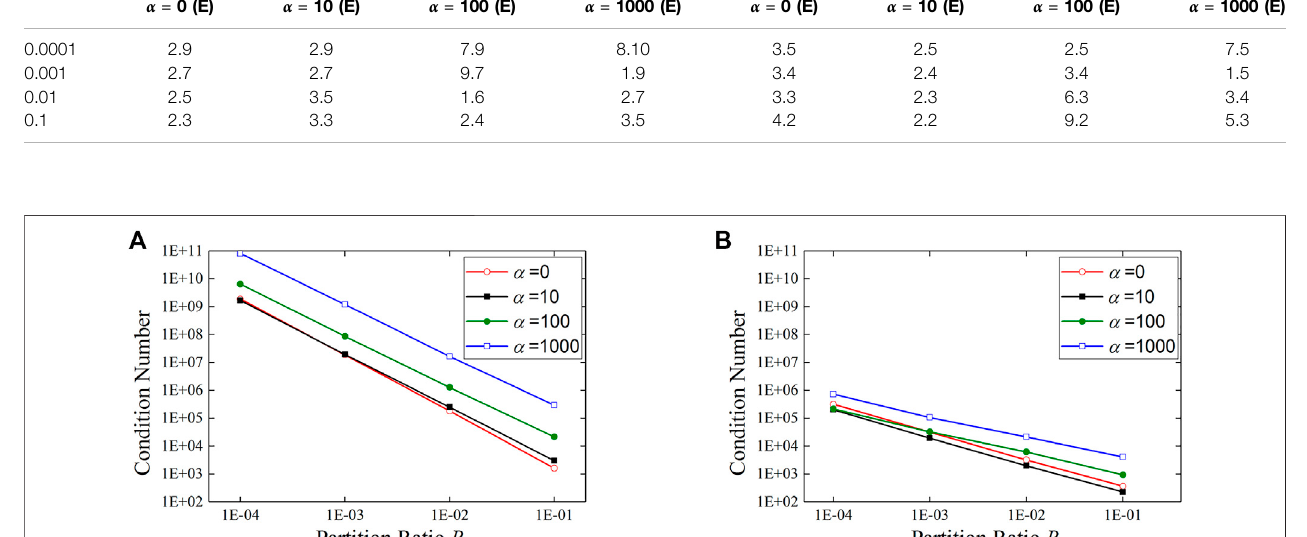
TABLE 2 | Condition numbers obtained using two integration methods with different penalty coef fi cients and partition ratios. R Subcell integration Smeared integration